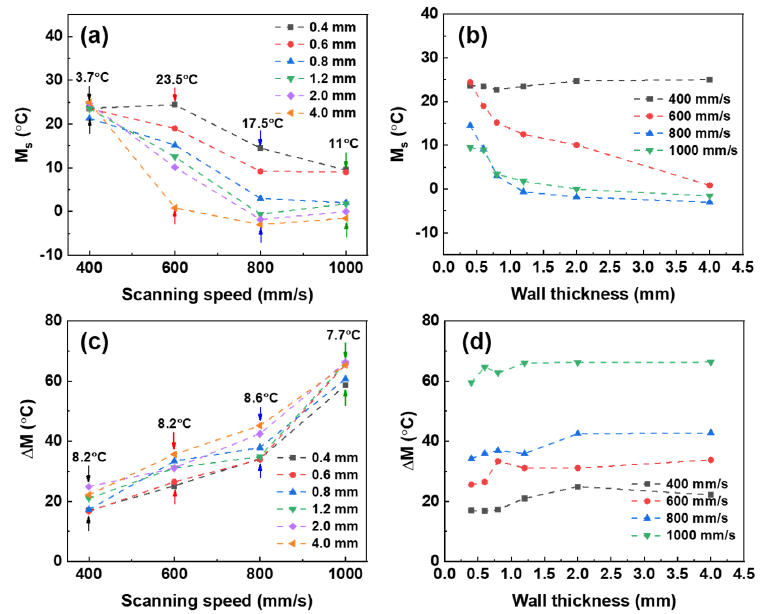
Figure 6. The martensitic transformation starting temperature ( M s ) and martensitic transformation peak width ( Δ M = M s − M f ) of SLM ‐ NiTi thin ‐ wall structures as a function of wall thickness and laser scanning speed: ( a ) evolution of M s with scanning speed; ( b ) evolution of Δ M with scanning speed; ( c ) evolution of M s with wall thickness; ( d ) evolution of Δ M with wall thickness.